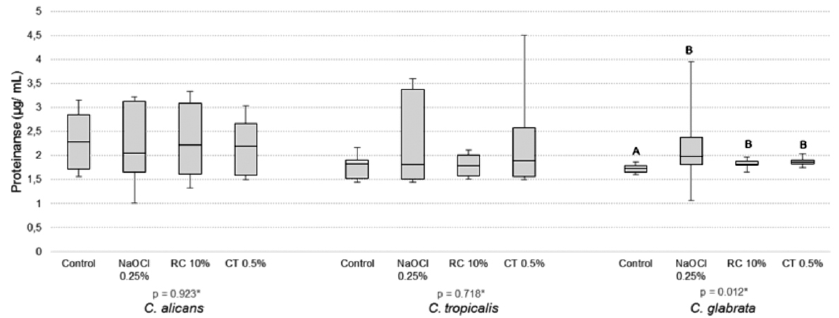
Figure 3- Comparison of proteinase (µg/ mL) production by Candida spp. after immersion of the specimens in the disinfectant solutions and water (Control)